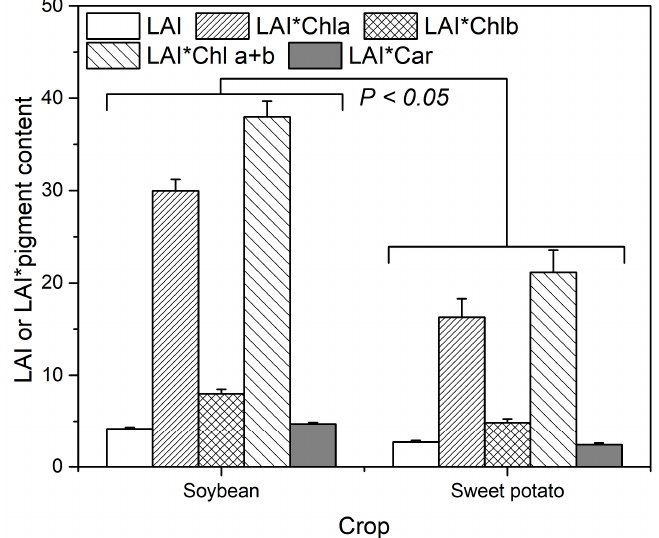
Figure 2. Comparisons of canopy pigment contents between soybean and sweet potato. The difference in the values between soybean and sweet potato were significant at the level of P < 0.05, which was determined using the one-way ANOVA (Tukey test). Error bars show the standard error of the mean.